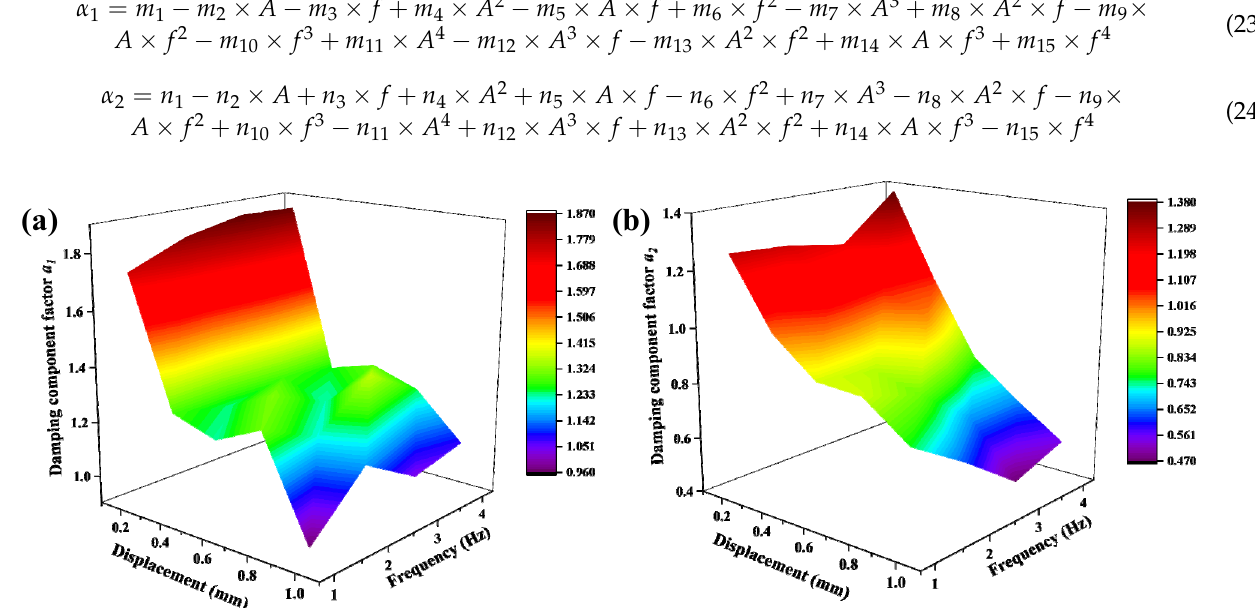
Figure 6. Variation trend of damping component factors with amplitude and frequency ( a ) a 1 and ( b ) a 2 . The fitting results are listed in Tables 7 and 8. Table 7. Fitting results of the damping coefficient a 1 .